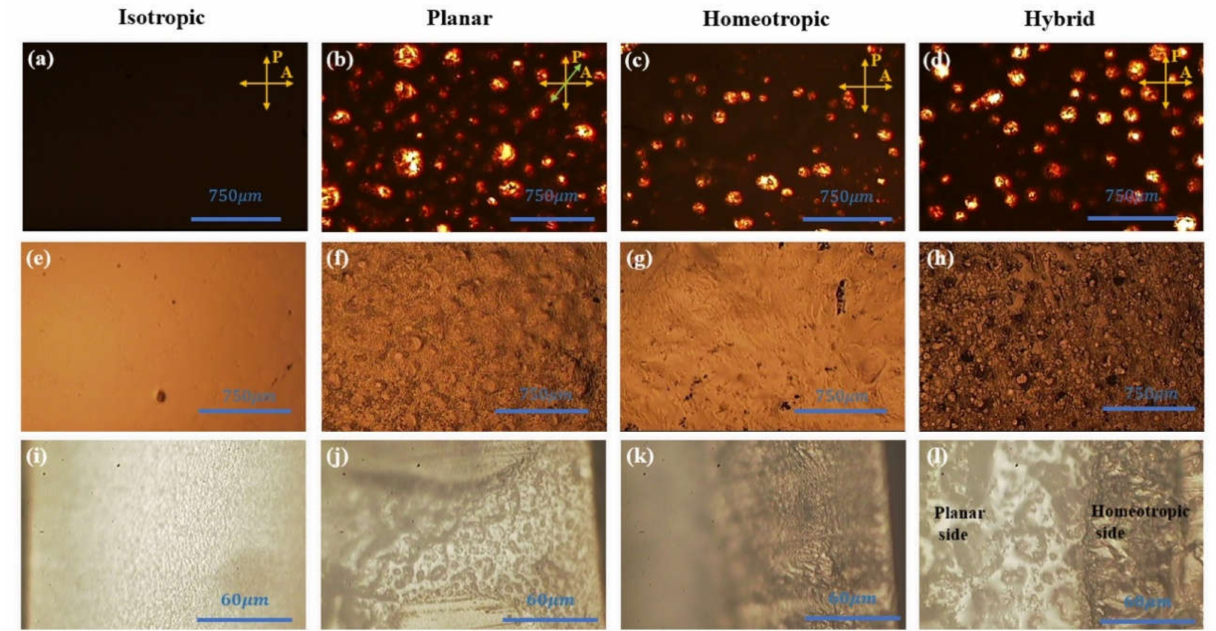
Figure 1. POM images of 200- µ m thick iLCE samples cross-linked in the isotropic phase (first column, a , e , i ), in the nematic phase between planar alignment substrates (second column, b , f , j ), between homeotropic alignment substrates (third column, c , g , k ), and in hybrid alignment between planar (top) and homeotropic (bottom) substrates (fourth column, d , h , l ). First row ( a – d ): top view of iLCE samples between cross polarizers in transmission. Second row ( e – h ): top view of iLCEs in reflection mode. Third row ( i – j ): cross section of iLCEs in reflection (the substrates are on the left and right and the director in planar alignment points normal to the picture